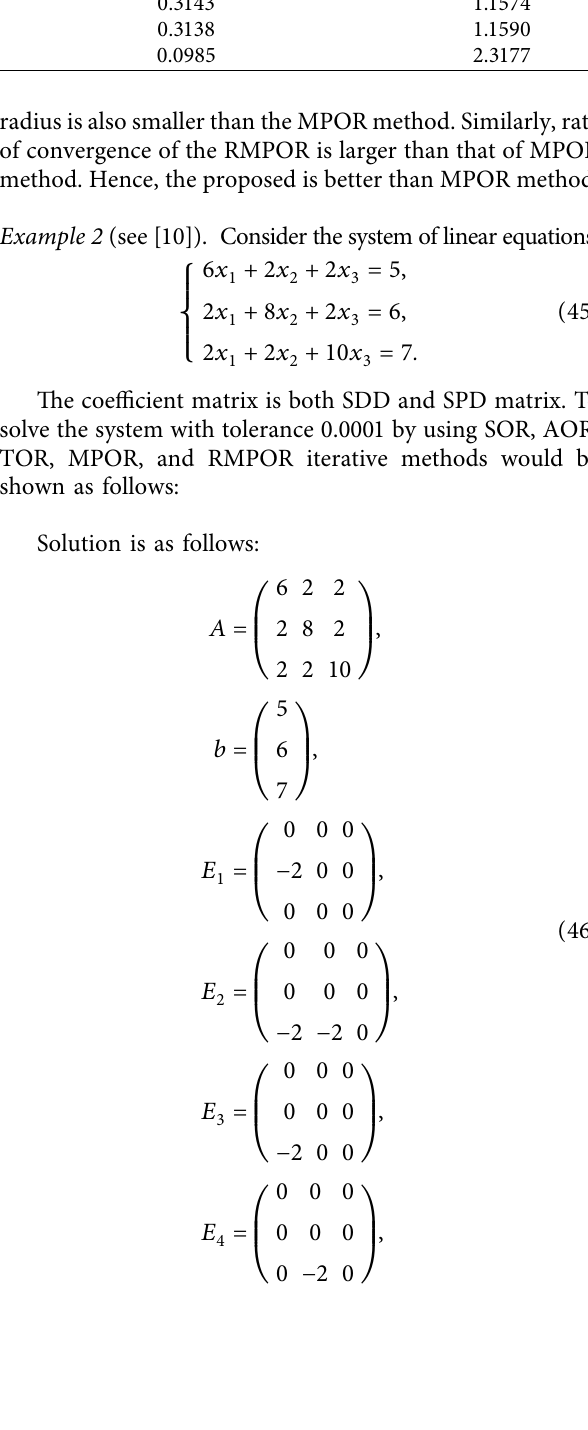
Table 2: Comparison of SOR, AOR, TOR, MPOR, and RMPOR methods for Example 2. Methods Number of iterations Spectral radius Rate of convergence � 1 . 01 SOR ( ω 0